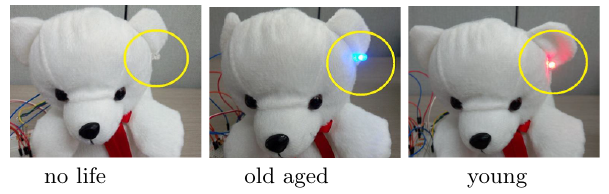
Figure 3: LED color changed by rest of life duration Table 1: Prepared characteristics of motion Characteristic Motion of head cheer(A) look upward, move left and right live-wired move left and right swiftly pessimistic look at the ground, move slowly laid-back move slowly toward up, down, left and